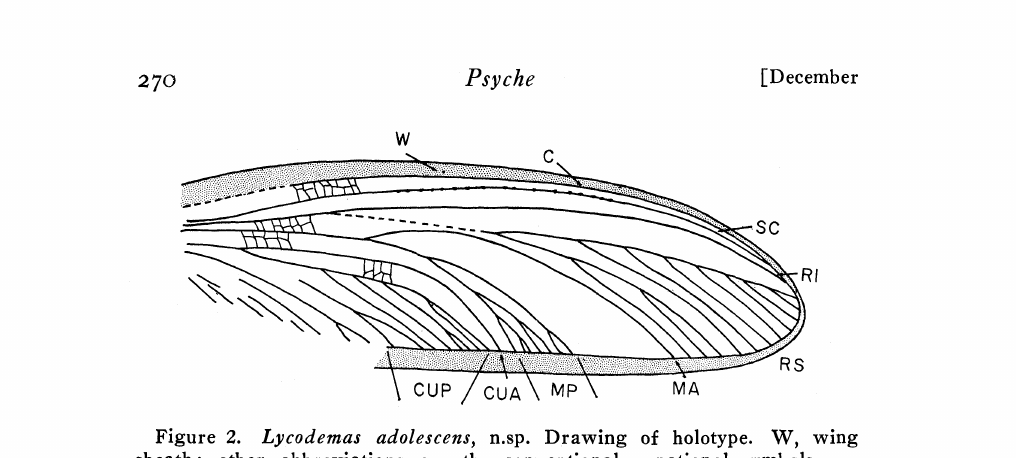
Figure 2. Lycodemas adolescens, n.sp. Drawing of holotype. W, wing sheath; other abbreviations are the conventional venational symbols. not visible in the wing pad but it presumably arises near the basal part of the wing, as indicated in the drawing. Rs has ten